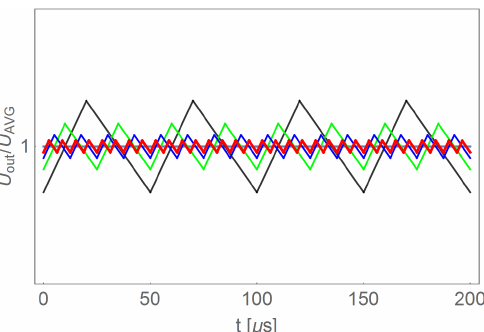
Figure 12. Simulated example waveforms of the supply voltage of an electronic commutator in a system with the use of an additional DC/DC converter for four different